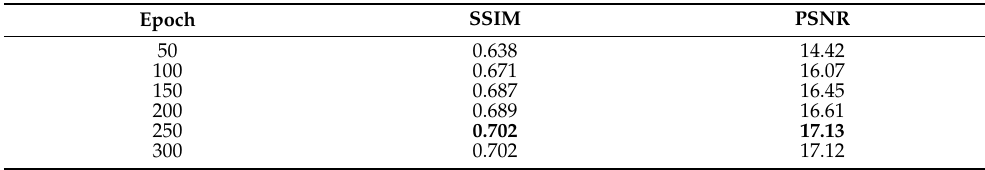
Table 5. Performance of the model under different